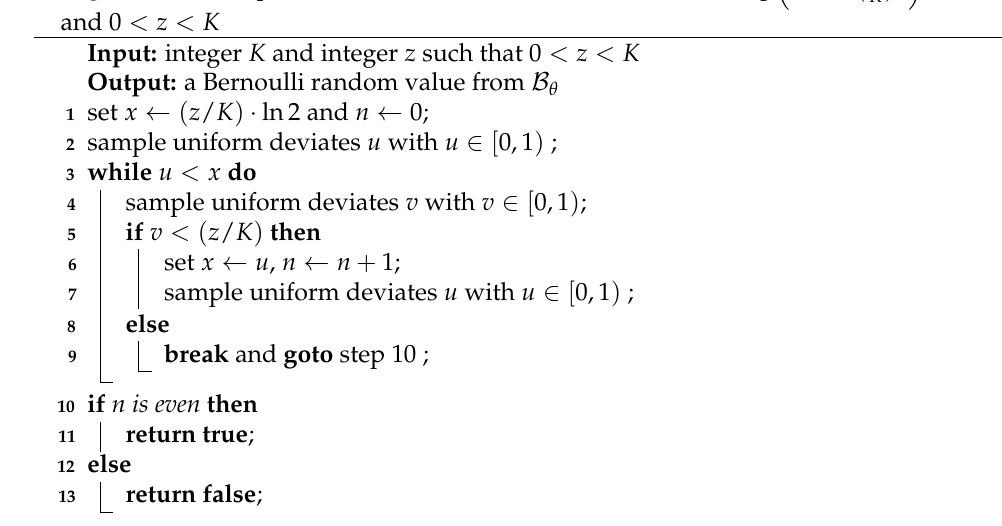
Algorithm 4: Sample from Bernoulli distribution B θ with θ = exp and 0 < z <